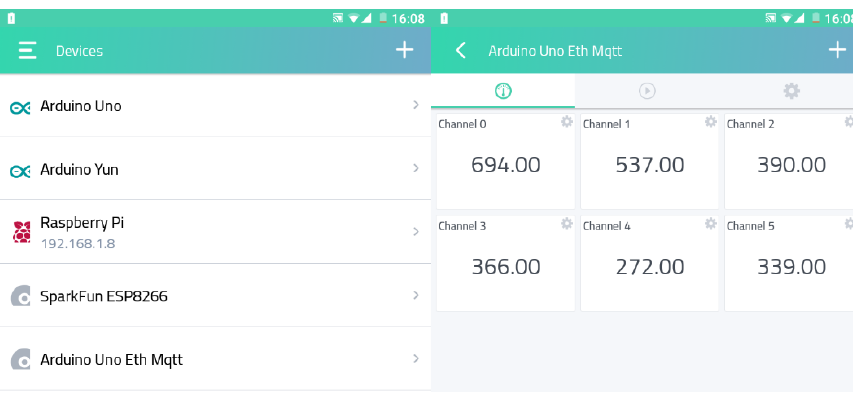
iJEP ‒ Vol. 8, No. 2, 2018